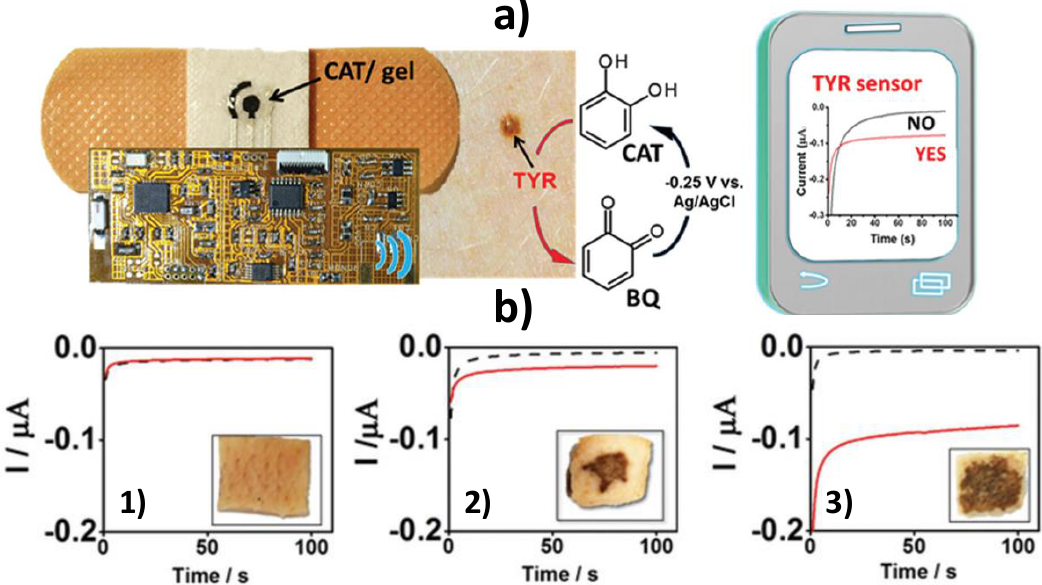
Figure 8. TYR biosensing using a bandage electrochemical sensor modified with a CAT-containing agarose gel and involving wireless chronoamperometric data transmission to a smart device ( a ). Chronoamperometric responses provided by the bandage sensors before (black line) and after (red line) 2 min interaction with skin pork samples untreated (1) and treated with 0.5 (2), and 2.5 mg mL − 1 TYR (3) ( b ). Reprinted and adapted with permission of Wiley [81].